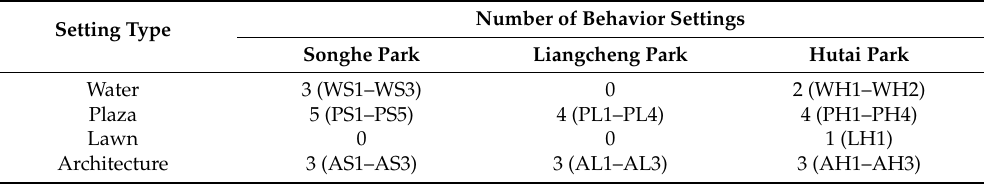
Note: Codes of the behavior settings are shown in parentheses.